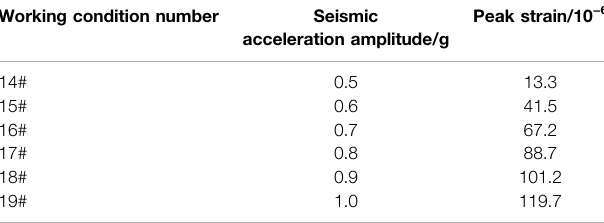
TABLE 3 | Peak strain of anti-seismic anchor cables in no-slip situation. Working condition number